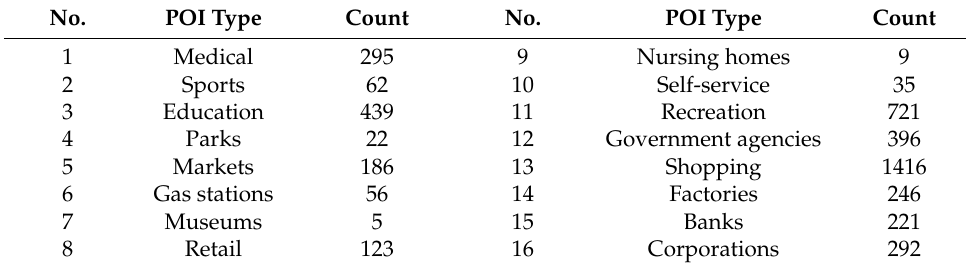
Table 2. Types and counts of POIs.